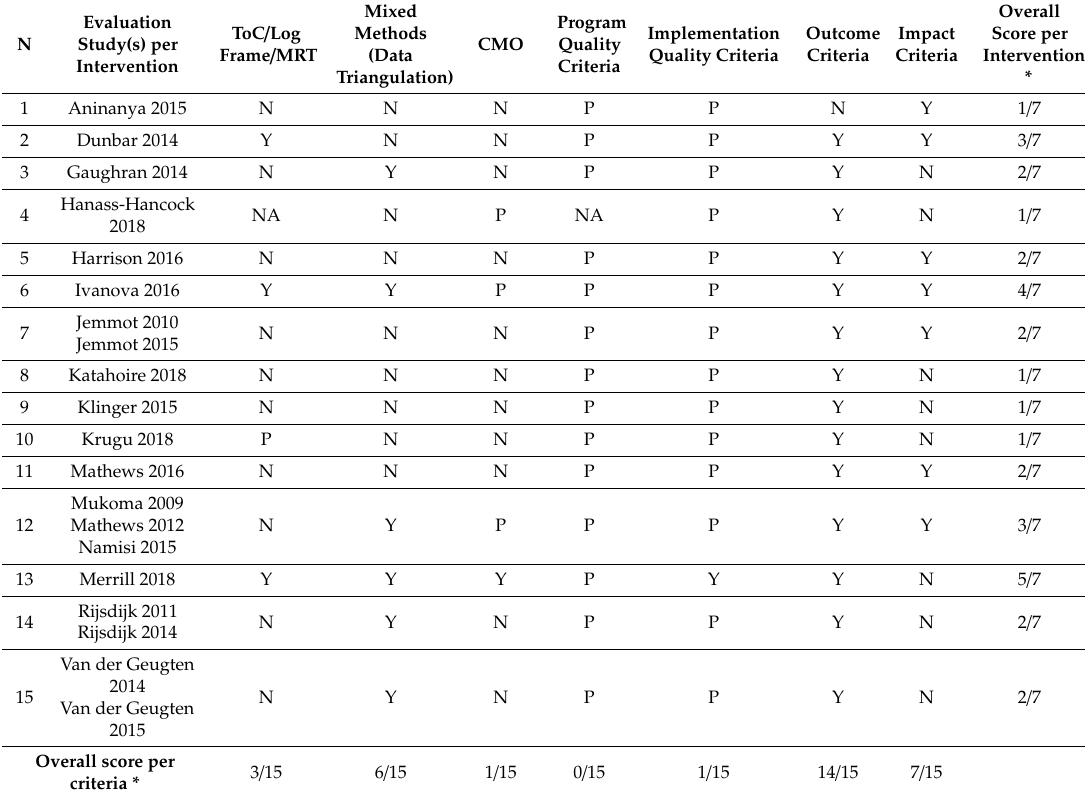
Table 3. Comparison to recommended frameworks for complex